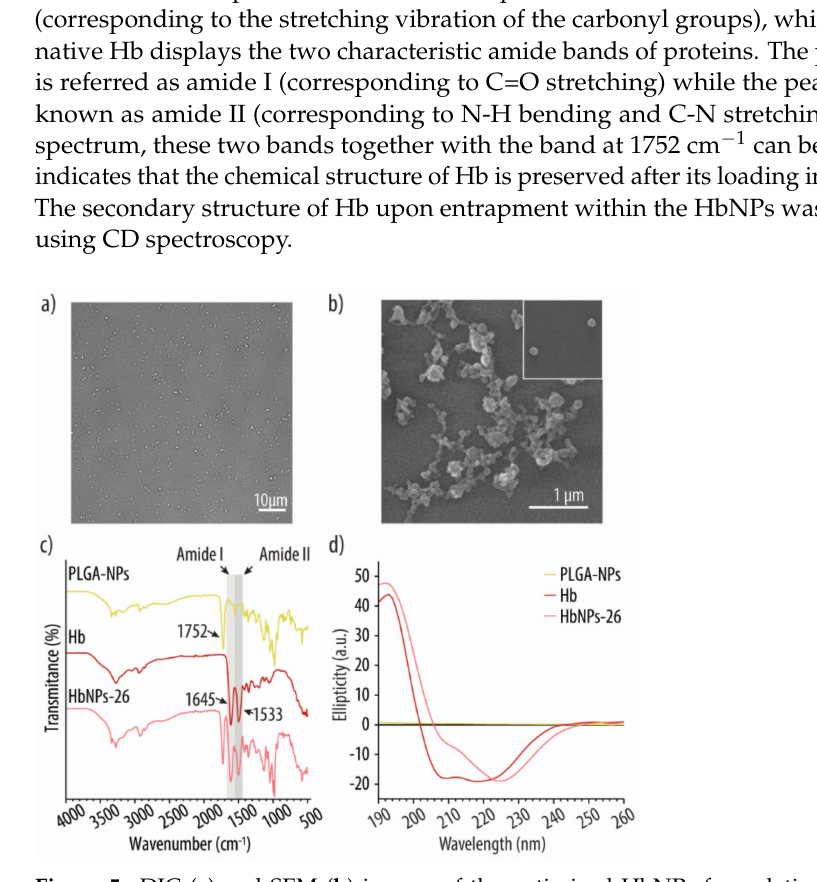
Figure 5. DIC ( a ) and SEM ( b ) images of the optimized HbNPs formulation. FTIR ( c ) and CD ( d ) spectra of PLGA-NPs, free Hb and the optimized HbNPs. The HbNPs were prepared using 75 mg mL − 1 Hb, 3 mg mL − 1 PLGA, and 0.5%